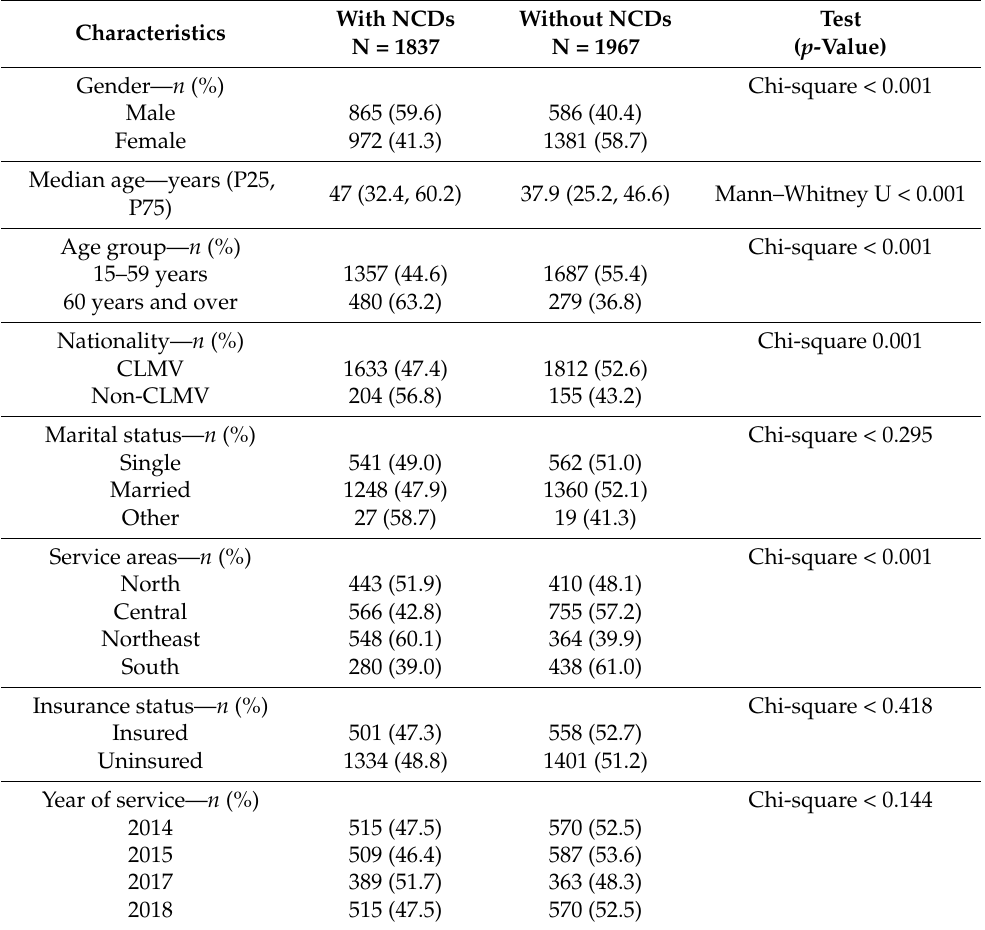
Table 3. Demographic characteristics of expatriate inpatients during